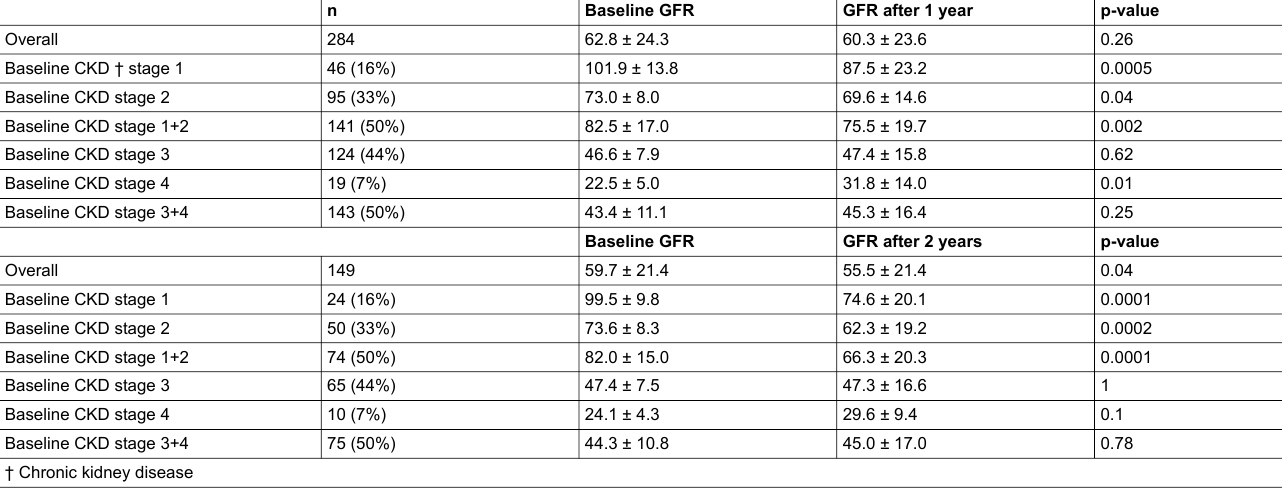
Table 2: Changes of mean glomerular filtration rate (GFR) according to baseline CKD stage after 1 and 2 years.